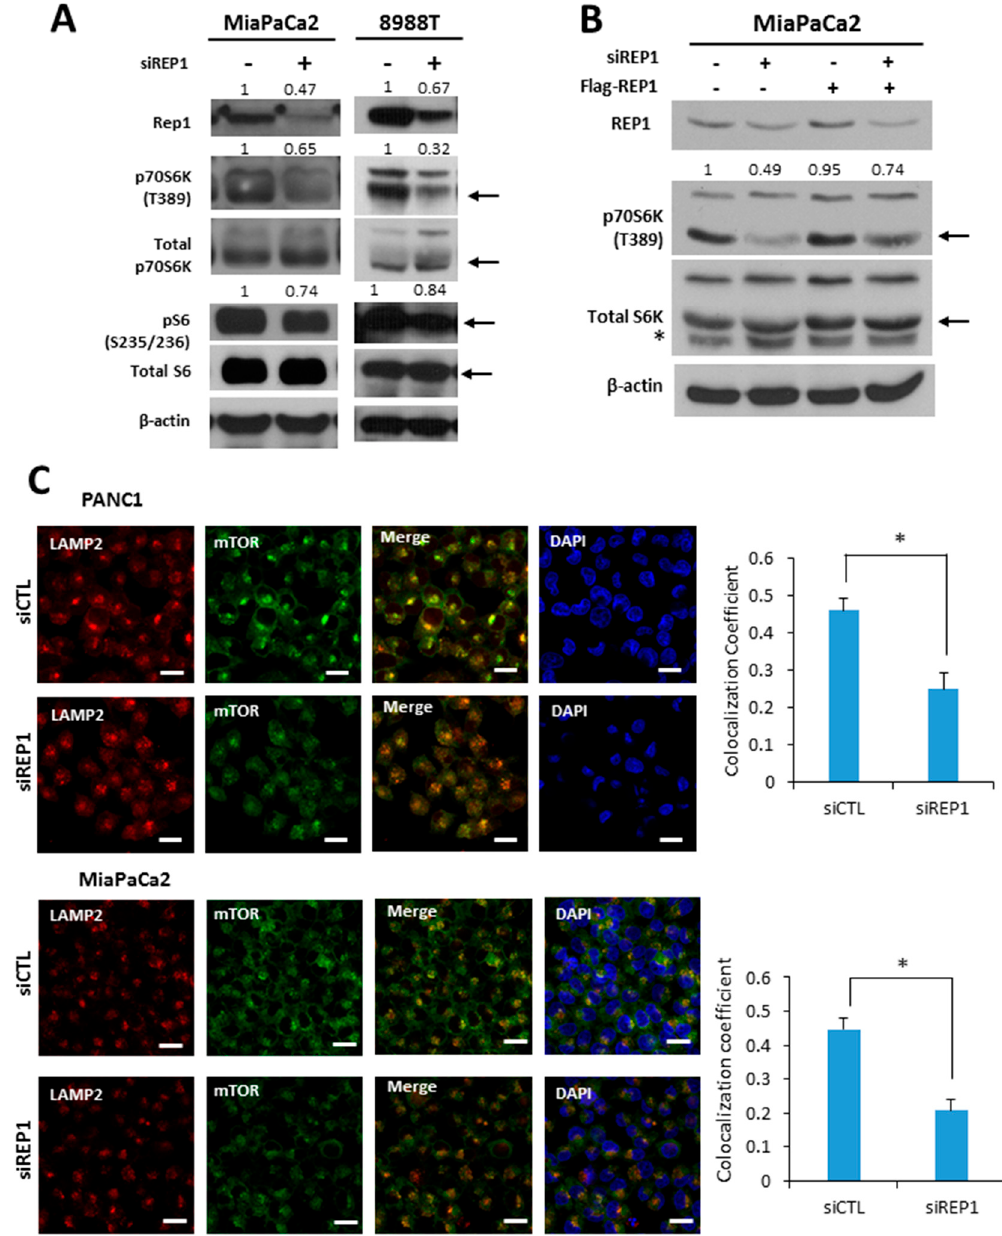
Figure 2. REP1 knockdown down-regulates mTORC1 signaling pathway. ( A ) Cells were treated with CTL orREP1siRNAs for 48 h. Then, cells harvested and the lysates were immunoblotted with antibodies against REP1, p70S6K, pS6, total 70S6K, S6 ribosomal (S6) protein, and beta actin; ( B ) MiaPaCa2 cells were with CTL or REP1siRN as for 24 h. Then, Flag-REP1 plasmid were transfected to the cells for overexpression, which were harvested and immunoblotted with antibodies against p70S6Kand a total 70S6K. These results are representative of three independent experiments; ( C ) cells were treated with CTL orREP1siRNAs for 48 h. After 2 h incubation in the presence or absence of amino acids, cells were stained with antibodies against mTOR and LAMP2, and analyzed by fluorescence microscopy to monitor mTOR localization. Co-localization coefficient was quantified by co-localization function of image-based software (ZEN) provided by the microscope system. Error bars indicate mean +/ − standard error for n = 3 independent experiments. Statistical significance was determined via a Student’s t -test;* p < 0.05. Scale bar: 20 μ m.